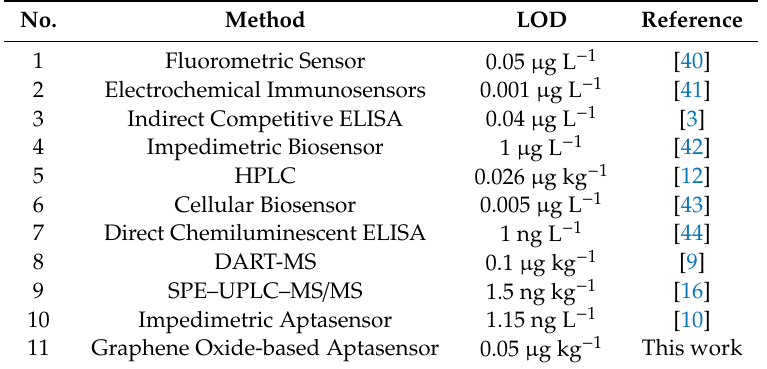
Table 1. Comparison of the sensitivity of currently available methods for the detection of AFM 1 .